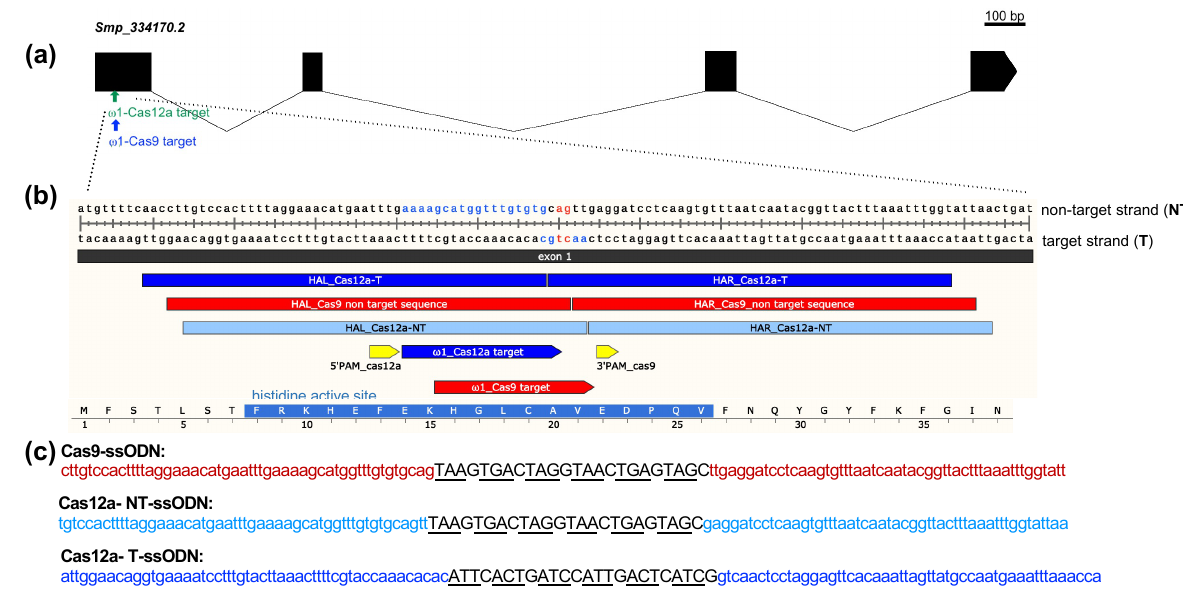
Figure 1. Schematic of the S. mansoni hepatotoxic ribonuclease omega 1 ( ω 1) gene structure, target sites for the Sp Cas9 and As Cas12a, ssODN donors, and partial amino acid sequence with histidine active site: ( a ) diagram of the ω 1 gene (Gene ID; Smp_334170.2 of S. mansoni annotated genome version 7_2021) and CRISPR/Cas target sites on coding sequence of the first exon coding for histidine active site, FRKHEFEKHGLCAVEDPQV. The relative positions of crRNA for CRISPR- Sp Cas9 (red arrow) and As Cas12a (blue arrow) are indicated, along with their 3 (cid:48) PAM (yellow arrow) and 5 (cid:48) PAM (yellow arrow), respectively; ( b ) programmed cleavage site for Sp Cas9/sgRNA ~3 nt upstream of PAM 3 (cid:48) TGG (red arrow); and cleavage site for As Cas12a/crRNA at 18–24 nt downstream of a prospective 5-’TTTV PAM (blue arrow). The programmed cleavage sites for both enzymes, Sp Cas9 and As Cas12a, were 3 to 6 nt distance from each other. Fifty residues upstream and downstream of the double-strand break (DSB) were included as the homology arms (HA) of the six-stop codon cassette transgene (payload/cargo). Because cleavage by Sp Cas9 liberates blunt-ended DNA, only a nontarget strand (NT) repair template was provided for HDR (red bar). Sticky-ended DNA results from cleavage by As Cas12a, and hence both nontarget and target strand (T) repair templates for HDR were provided (light and dark blue bars); ( c ) the DNA donor sequences of CRISPR/ Sp Cas9 (red letters) and CRISPR/ As Cas12a with nontarget (light blue letters) or target sequence (dark blue letters) HA where the Cas12a-NT-ssODN donor repairs the antisense DNA and Cas12a-T-ssODN donor repairs the sense